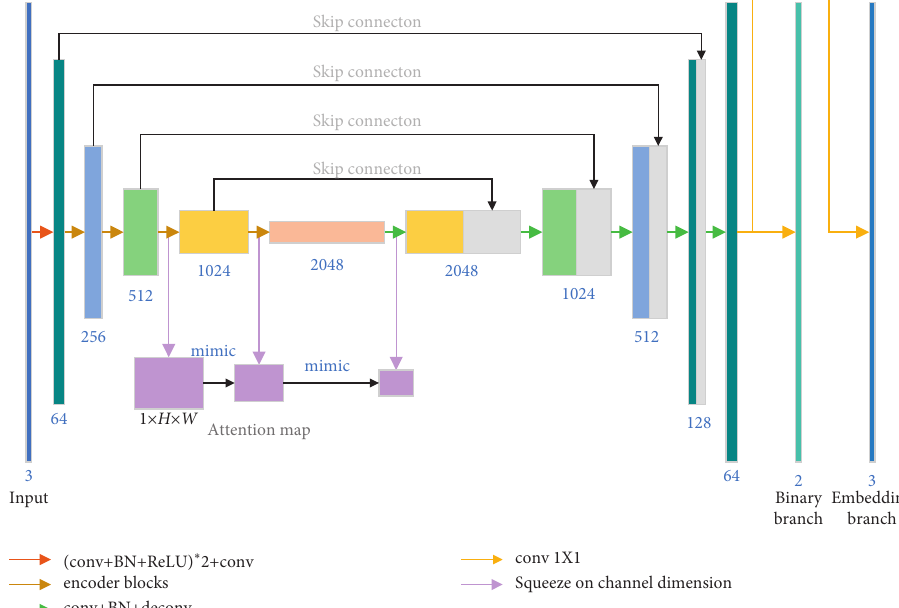
Figure 3: Network structure. Conv is a convolutional layer (convolution kernel is 3 × 3), deconv denotes the transposed convolution, BN denotes batch normalization, and Relu is the activation layer. Conv 1 × 1 is a convolutional layer with 1 × 1 kernel. Encoder blocks are shown in Figure 4. Blocks of the same color represent they have the same number of channels. Those gray ones mean they are from